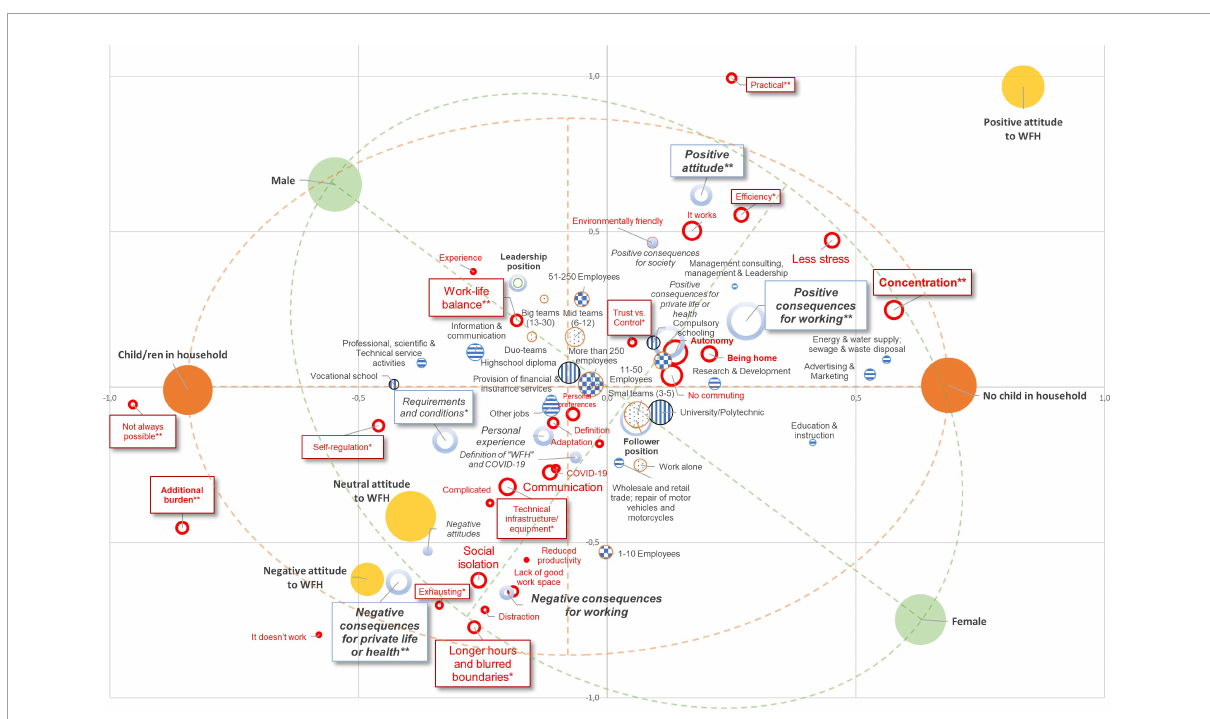
FIGURE2 CATPCA-biplot: dimension 1: 39.8%; dimension 2: 29.8%. Fully colored circles represent the seven categories of the three main variables of our analysis ( gender : “male”/“female” in green, children in household : “child/ren in household”/“No child in household” in orange, evaluations of associations : “positive attitudes towards WFH”/“neutral attitudes towards WFH”/“negative attitudes towards WFH” in yellow). The size of the circles represents the frequency (mass) of each category (the bigger the circle, the more frequent the category). The proximity of circles may be directly interpreted in terms of their correspondence to the three main variables. Italic letters indicate the superordinate categories. Red fonts indicate the 29 categories. Category labels with framing indicate their significant over- and/or under-representations as reported in Table 2 (superordinate categories) and Table 3 (semantic categories). To ease the interpretation, we added two orthogonal axes (dotted lines) aligned with (1) the poles of gender variable in green and (2) the poles of household condition in orange. The circles without filling colors (education = horicontal lines; number or persons in teams: dots; industry: vertical lines; size of the organization: squared); represent the categories of supplementary variables added to CATPCA. Their mass is not considered in the analysis (Hjellbrekke, 2018) and facilitates the interpretation of the bidimensional Euclidean